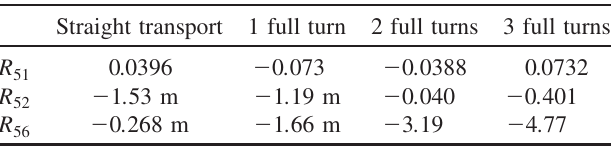
LASER-INDUCED NARROWBAND . . TABLE I. Transport matrix parameters corresponding to dif- ferent transport paths from the undulator to the THz beam line bending magnet: Direct transport, transport involving one full turn in the storage ring, 2 turns, etc.